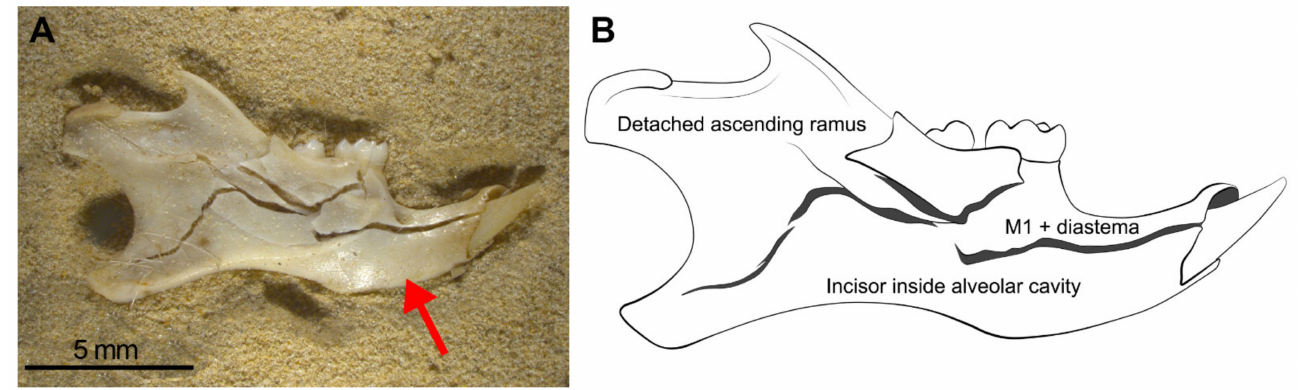
Figure 7. Most mandibles follow this pattern of breakage in which mandible fragments remain joined together, although with minimum movement or processing (sieving, sorting), this specimen will split into pieces. ( A ) Photo of the breakage pattern of mandibles. ( B ) Detailed scheme. The red arrow points to the incisors in the interior of their sockets.